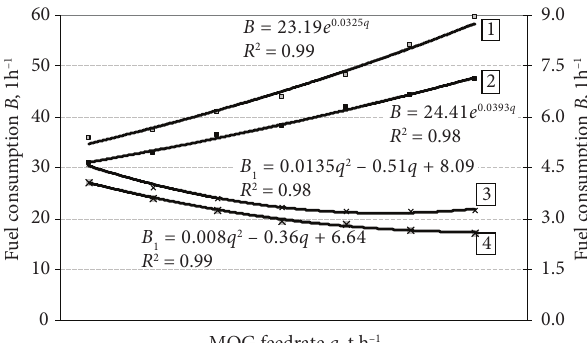
Figure 4. Effect of MOG mass of WOSR Visby fed to combine harvester B on the hourly fuel consumption ( B ) and on 1 ton of seed threshing ( B 1 ) when the stubble height h = 0.3 m and straw chopper rotor n 1 = 3300 rpm. (1) represents hourly fuel consumption when stems are chopped, (2) represents hourly fuel consumption when stems are incorporated in windrows, (3) represents fuel consumption per ton of threshed seeds when stems are chopped, and (4) represents fuel consumption per ton of threshed seeds when stems are incorporated in windrows